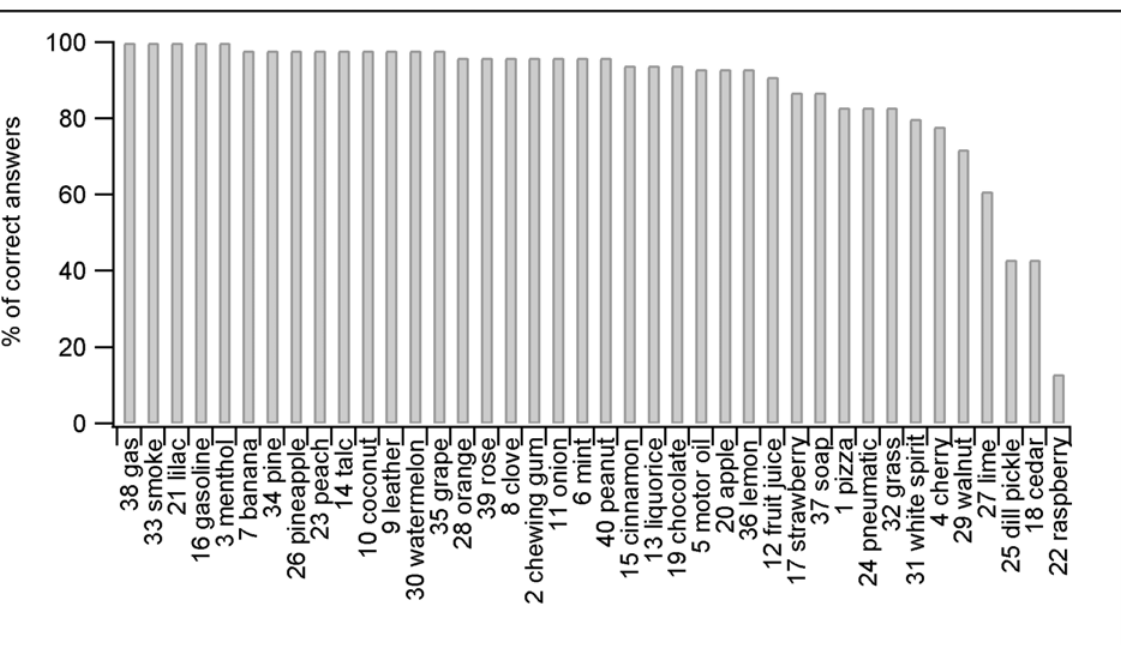
Figure 1. Distribution of answers to the Italian UPSIT test. Percentage of correct answers to the 40 odorants of the Italian version of the UPSIT smell identification test by the healthy subjects (n =